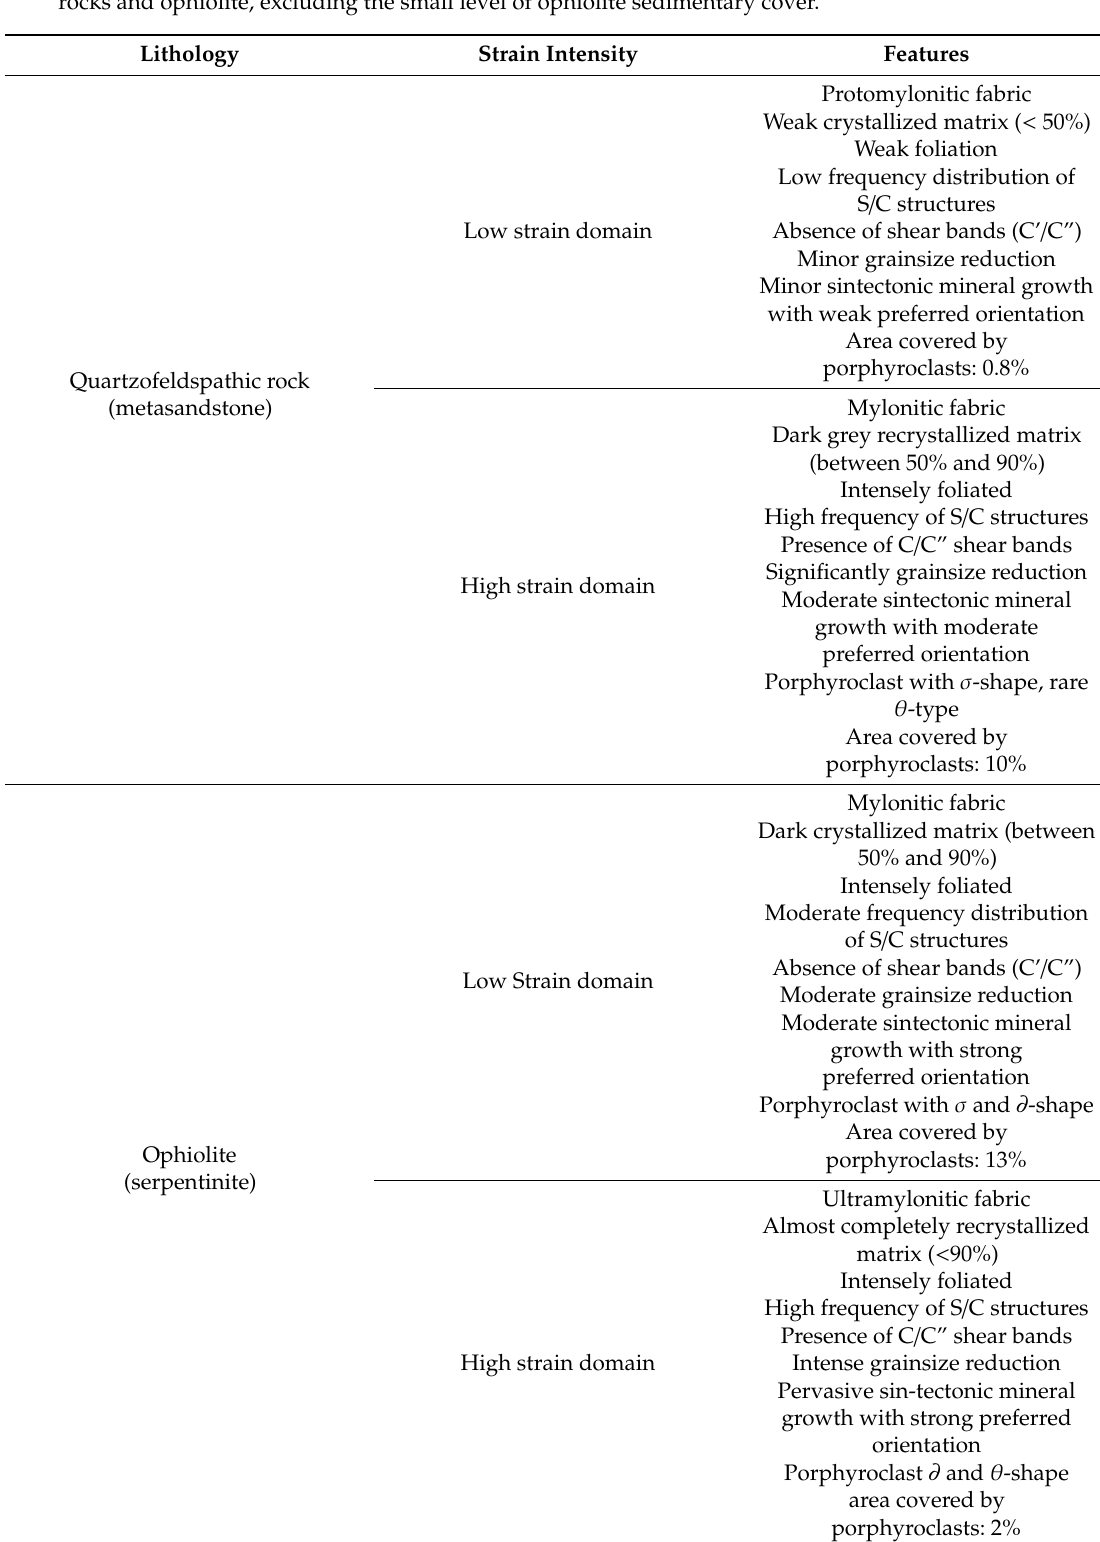
Table 1. Descriptive strain intensity Capo Castello shear zone domains within quartzo-feldspathic rocks and ophiolite, excluding the small level of ophiolite sedimentary